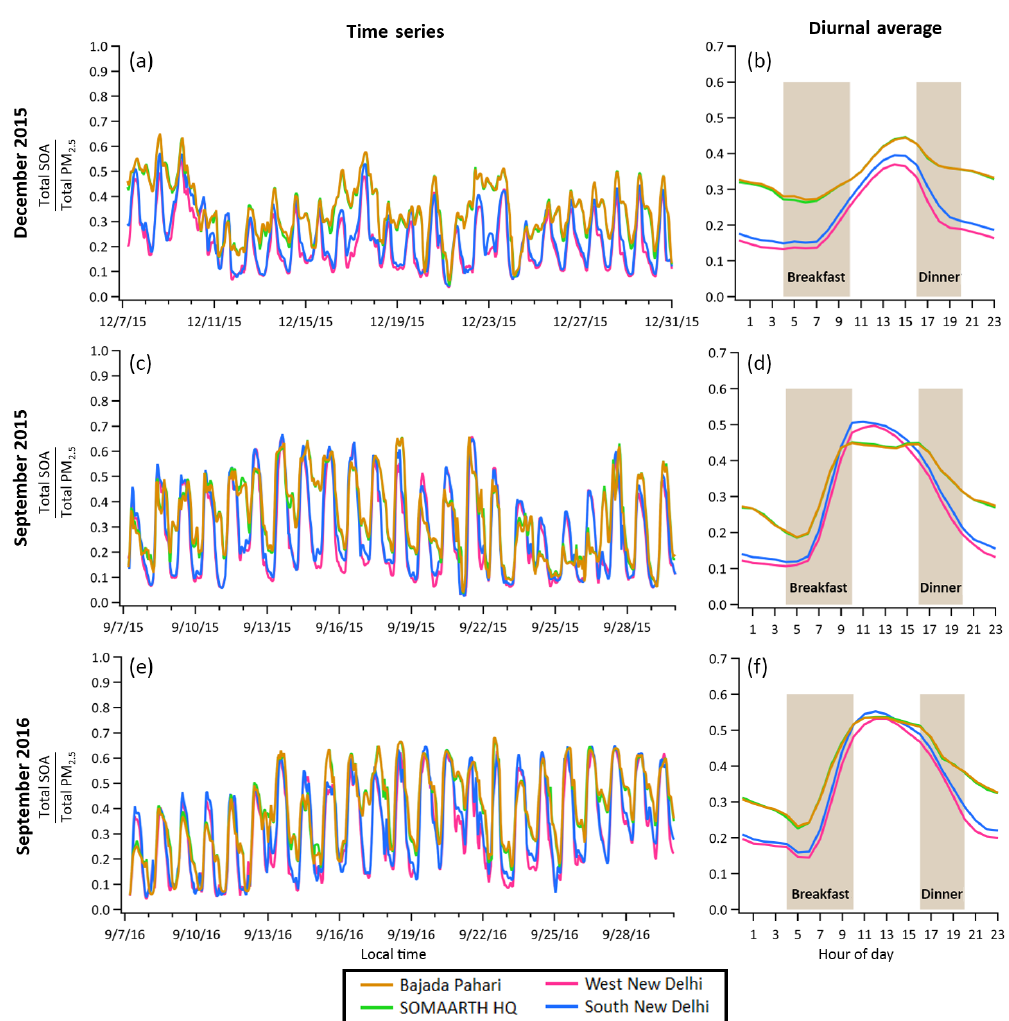
Figure 12. Predicted Total SOA (a, c, e) and average diurnal cycle (b, d, f) for 20–31 December 2015 (a, b) , 7–30 September 2015 (c, d) , Total PM 2 . 5 and 20–30 September 2016 (e, f) . Bajada Pahari is shown in yellow, SOMAARTH HQ in green, West New Delhi in pink, and South New Delhi in blue. Diurnal profiles were averaged over simulation durations (Table 7). Computations were carried out at 4km resolution.